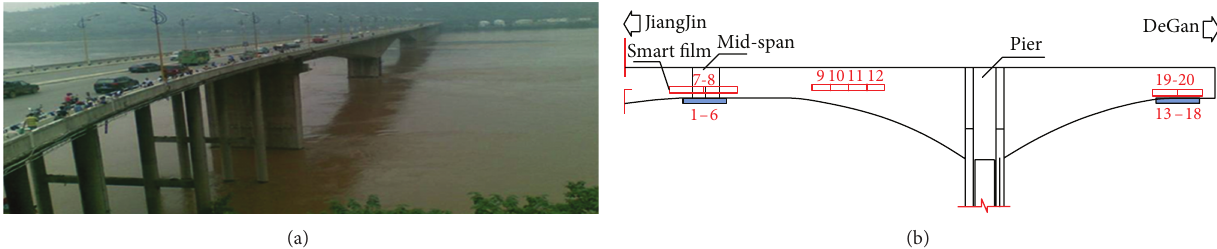
Figure 20: Jiangjin Yangtze River Highway Bridge and its sensor layout.